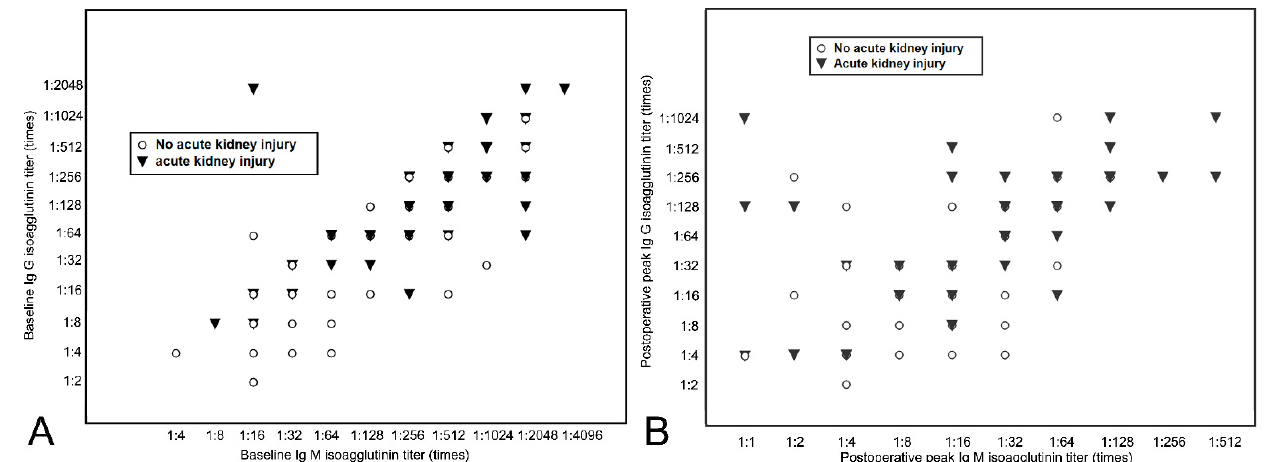
Figure 1. Distribution of the initial baseline ( A ) and postoperative peak ( B ) Ig G and Ig M isoagglutinin titers of the patients ( n = 130). Ig = immunoglobulin. Data symbol is depicted where there is a case with each specific Ig G and Ig M titer.